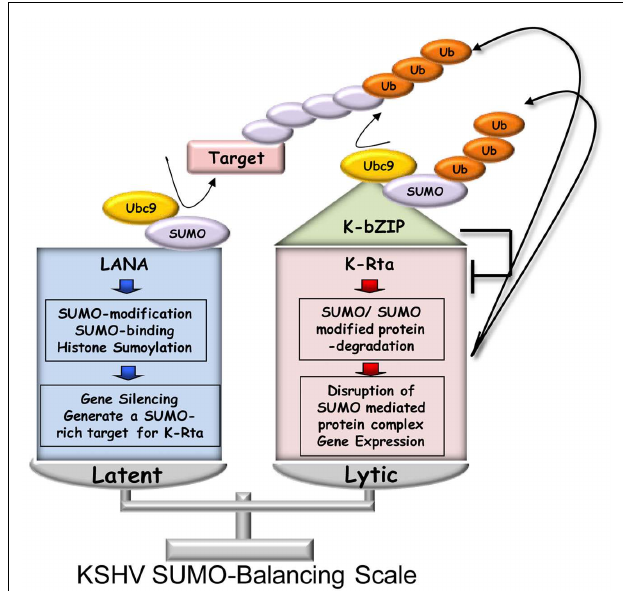
FIGURE 6 | KSHV SUMO-dependent balance. The outcome of the KSHV life cycle is depicted as a balance between the functions of the viral factors LANA, K-Rta, and K-bZIP which are mediated through their SUMO-dependent activities.The SUMO E3 ligase activities of K-bZIP and LANA and the STUbL activity of K-Rta are shown (see text for